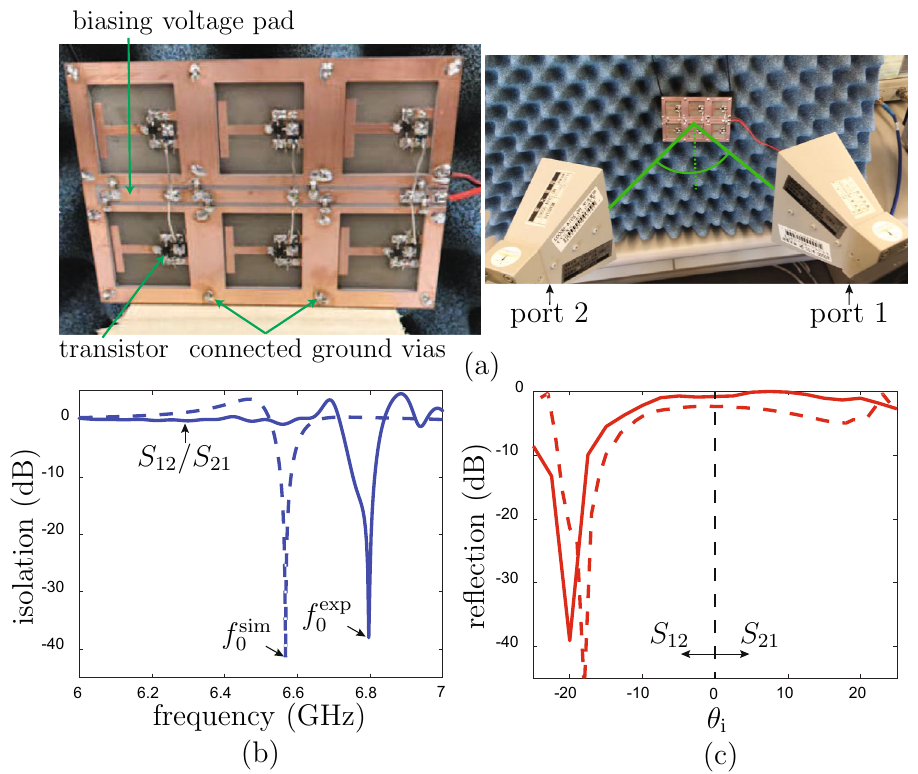
Figure 5. Experiment. ( a ) Fabricated prototype (left) and experimental setup (right). ( b ) Isolation versus frequency for incidence at θ i = ± 20 ◦ (maximal isolation angle). ( c ) Specular reflection coefficient versus exp 6.797 GHz. The dashed lines correspond to the incidence angle ( θ i ) the operating frequency of f 0 = simulation results of Fig.